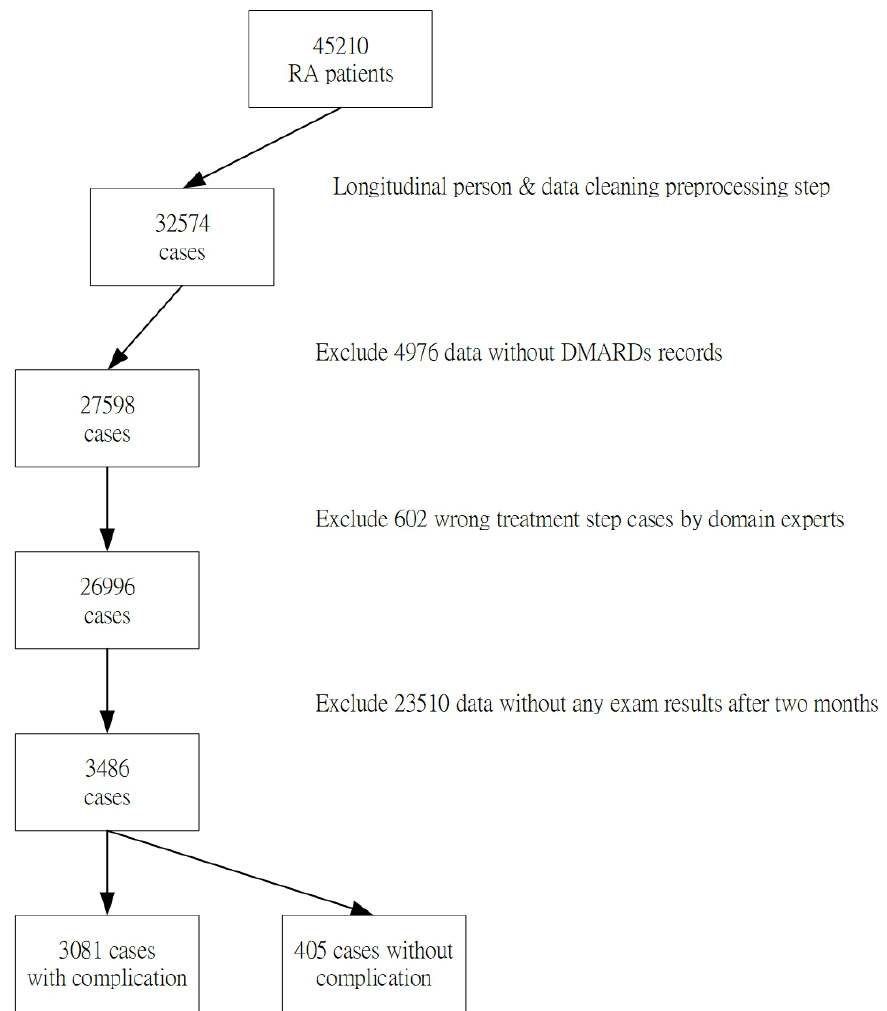
Figure 1 . Flowchart showing derivation of the study sample. Figure 1. Flowchart showing derivation of the study